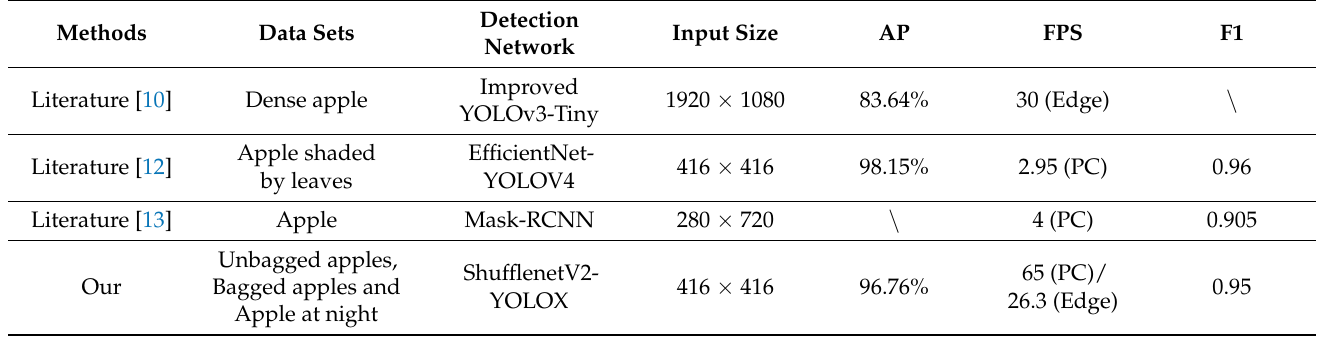
Table 5. Comparison between ShufflenetV2-YOLOX and existing detection